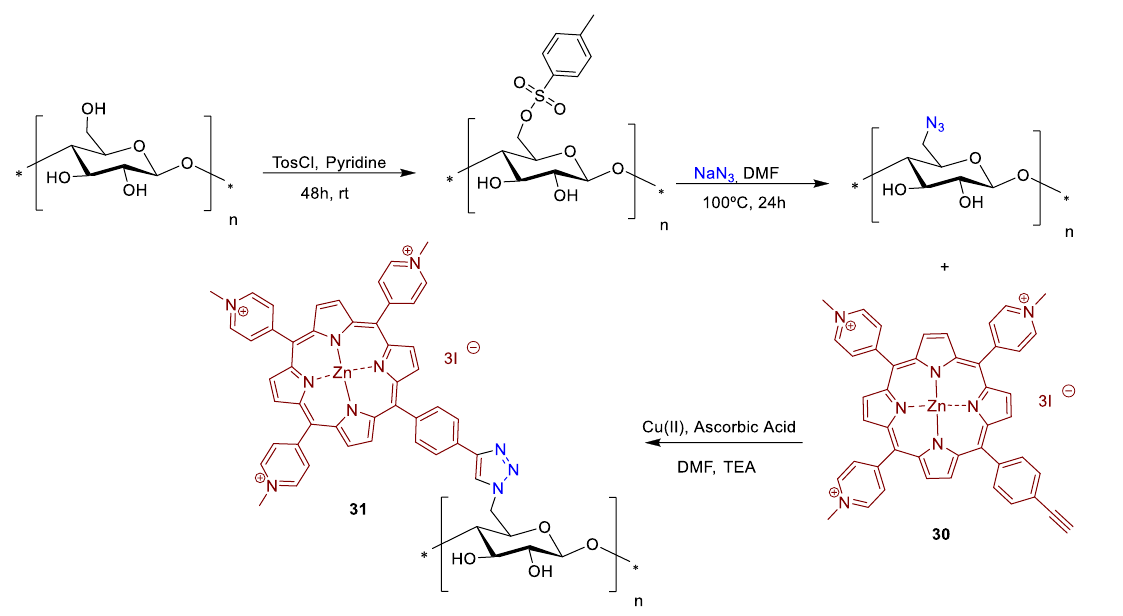
Figure 23. Ghiladi grafting method to prepare material 31 by covalently grafting the tricationic porphyrin 30 bearing an alkynyl function to cellulose nanocrystals or cellulose fibers ( Whatman #1 filter paper) bearing azide moieties (Adapted from Refs. [168 – 170] ).